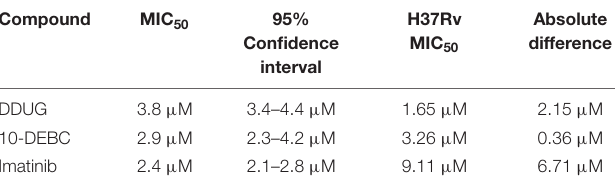
TABLE 2 | Activity of host-directed compounds on intracellular M.tb strain MC 2 6206. Compound